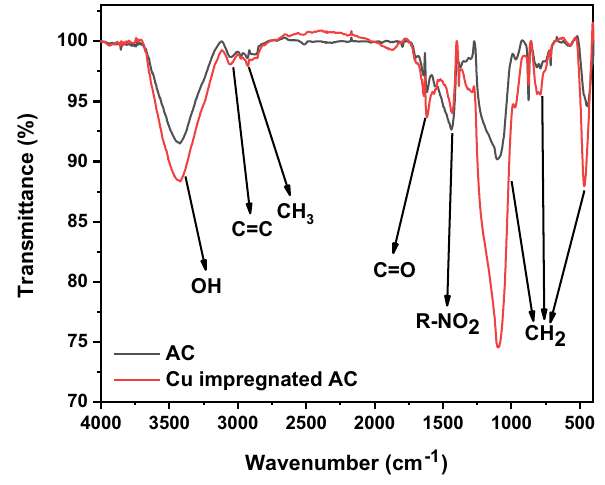
Fig. 2 FTIR spectra of the activated carbon and Cu-impregnated